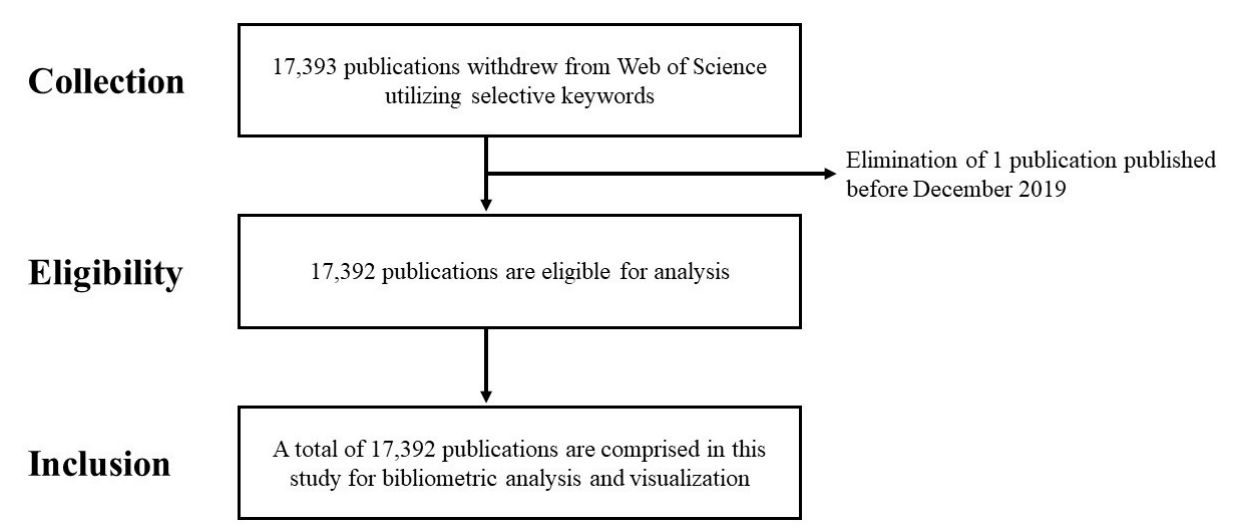
Figure 3. The flowchart of selecting core publications on COVID-19 vaccine.